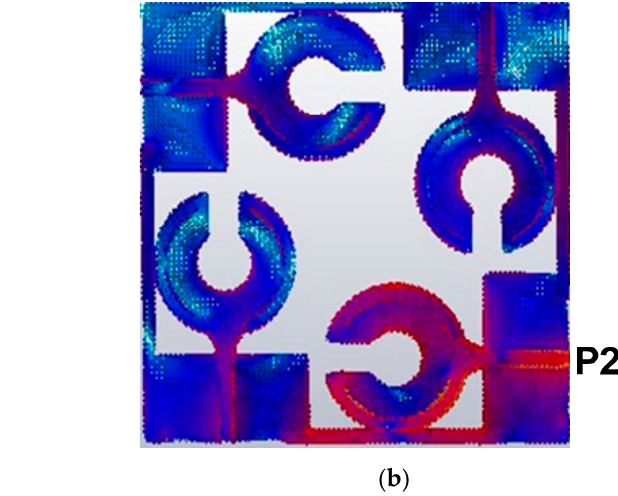
Figure 7. Surface current density distribution at 3.5 GHz over the proposed antenna array, ( a ) exci- tation at port 1 and ( b ) excitation at port 2.